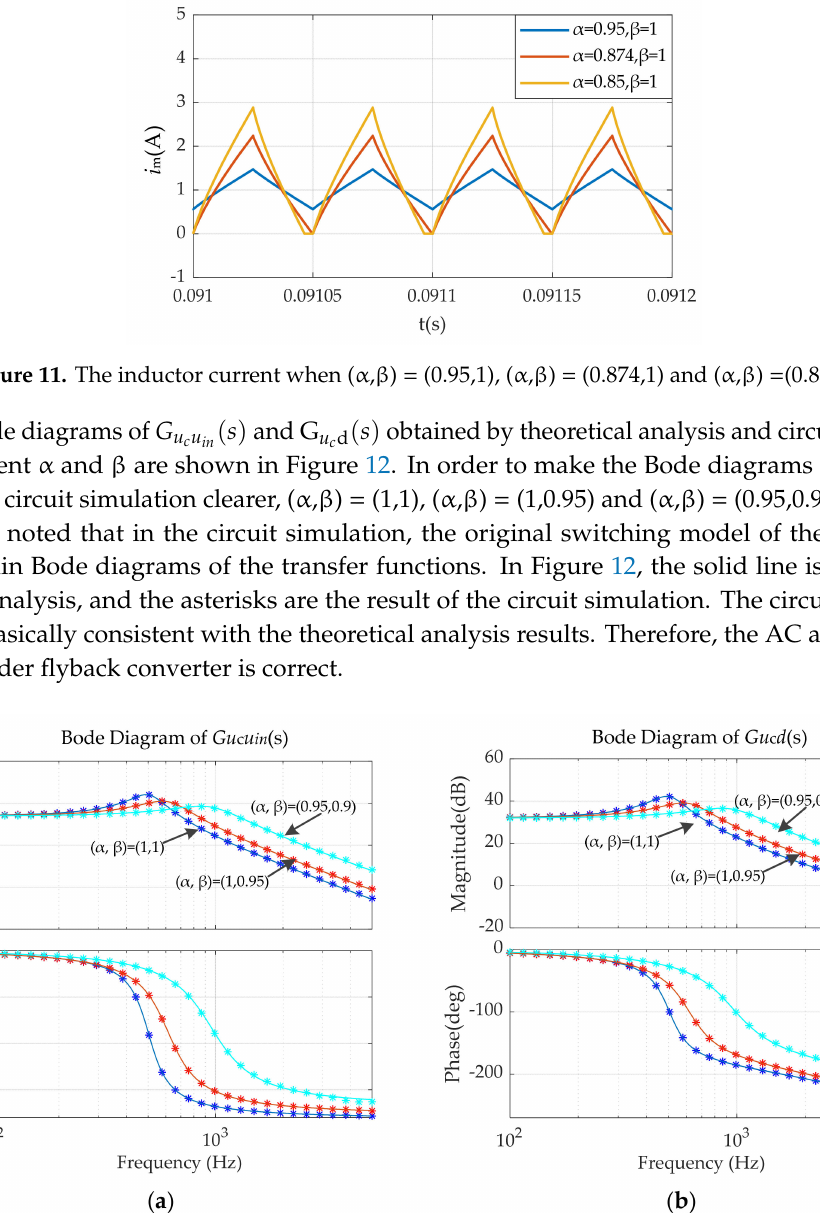
Figure 12. ( a ) The Bode diagram of G u under di ff erent α and β . ( b ) The Bode diagram of G u simulation under di ff erent α and β